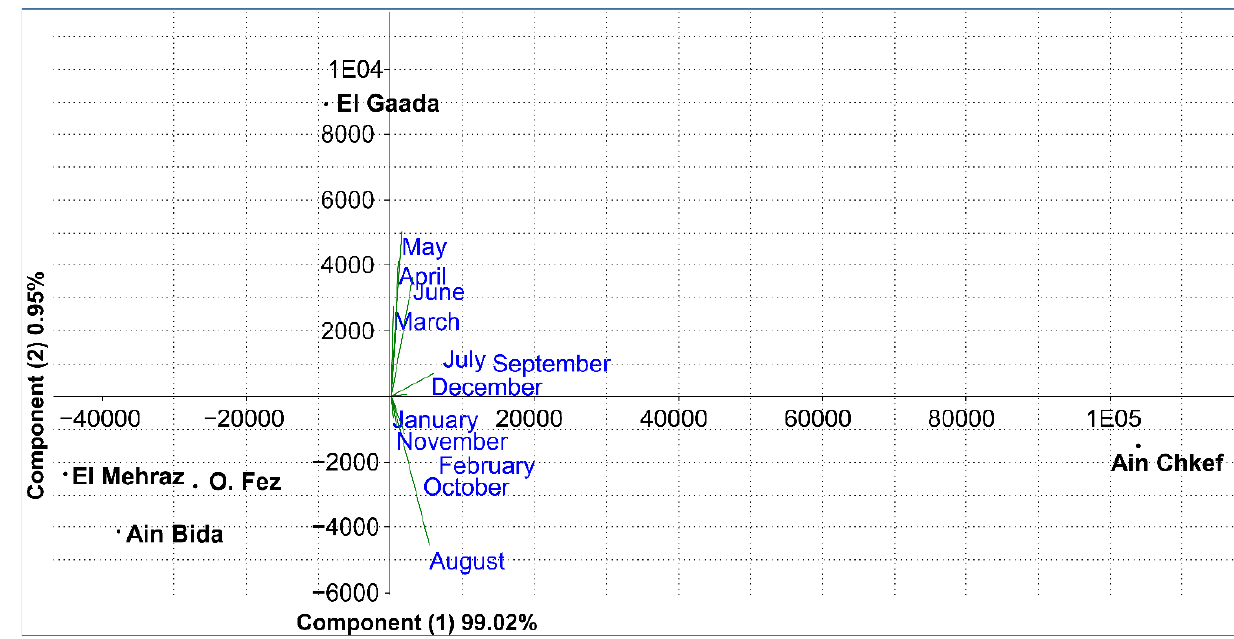
Figure 6. Periods of tourists visiting studied sites between 2018 and 2019.